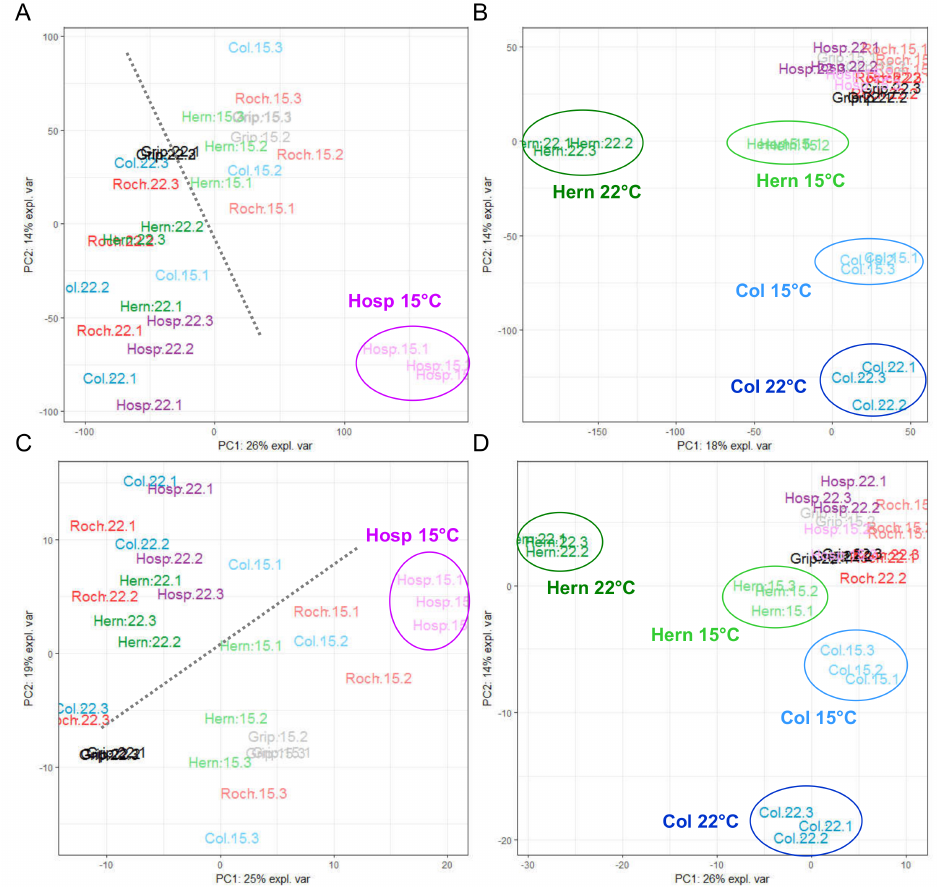
Figure 5. Overall comparisons of the transcriptomes of Col, Roch, Grip, Hern and Hosp grown at 22 ◦ C (bright colors) or 15 ◦ C (pale colors). Scaled PCA of the “whole transcriptome”: ( A ) rosettes; ( B ) floral stems. Scale PCA of the “CW transcriptome”: ( C ) rosettes; ( D ) floral stems. The ellipses focus on the specific profiles discussed in the Results section. The grey dotted lines indicated the separation of the samples according to the growth